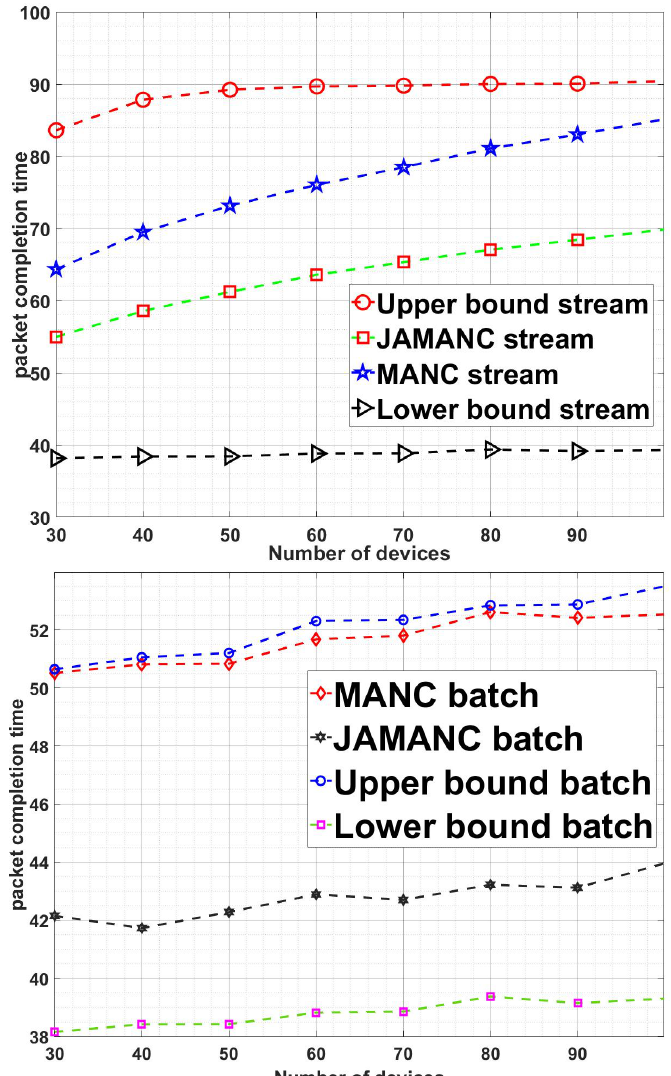
Figure 12. Packet Completion vs. no. of devices (lossy second